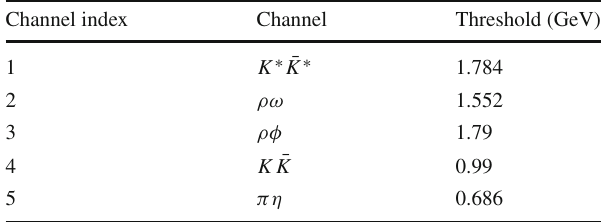
Table 2 Channel indices and threshold